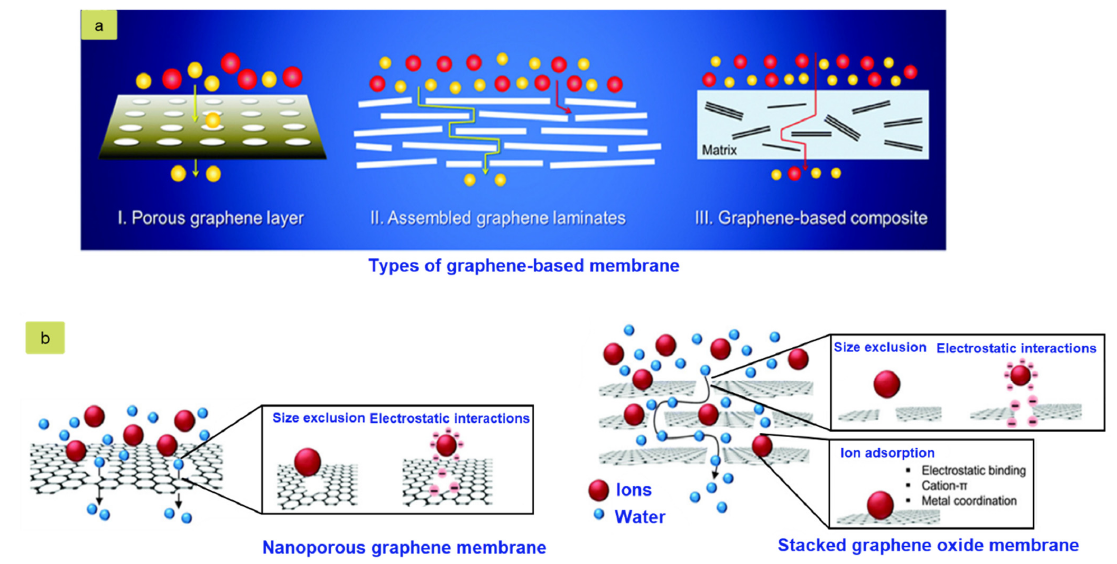
Figure 14. Schematic diagram of ( a ) Different types of graphene-based membranes, ( b ) Water separation membrane; Re- printed with permission [244].